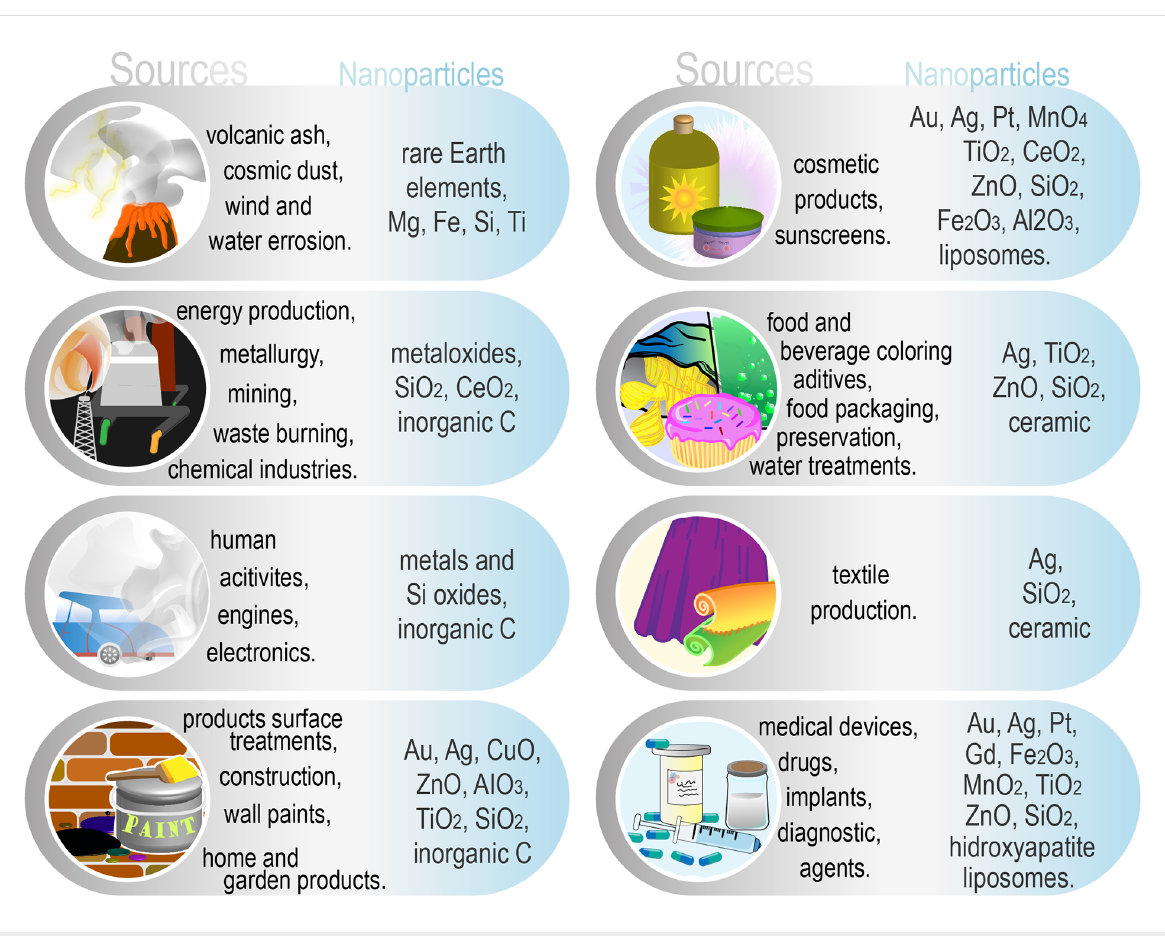
Figure 1: Common sources and types of nanoparticles that we come in contact with